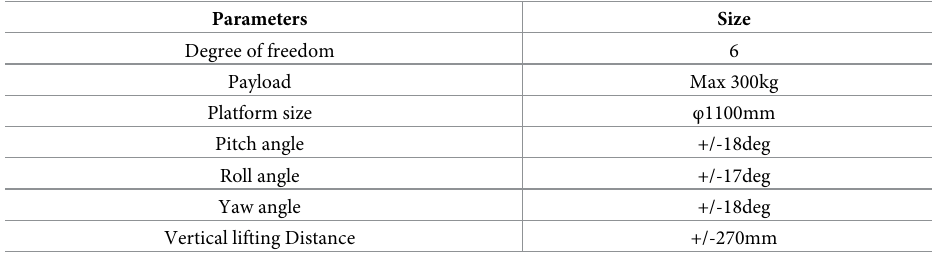
Table 1. Parameters of vibration